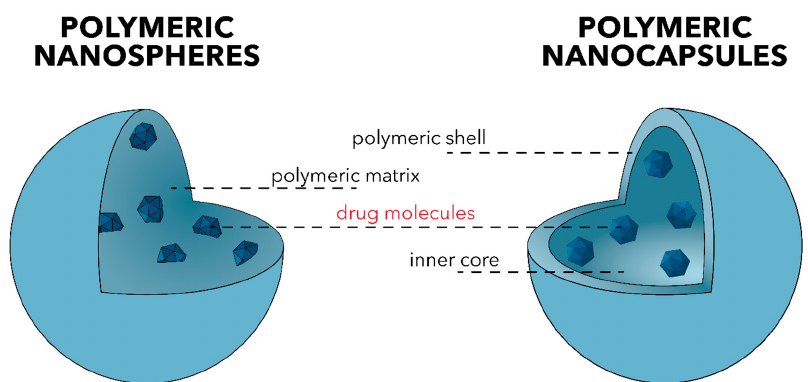
Figure 6. The two main types of polymeric nanoparticles—polymeric nanospheres ( left ) and polymeric nanocapsules ( right ).